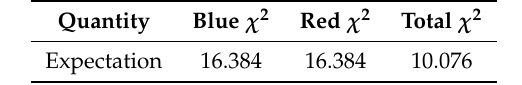
Table 5. The χ 2 fit for the overall expected value of forced monochromatic triangles.